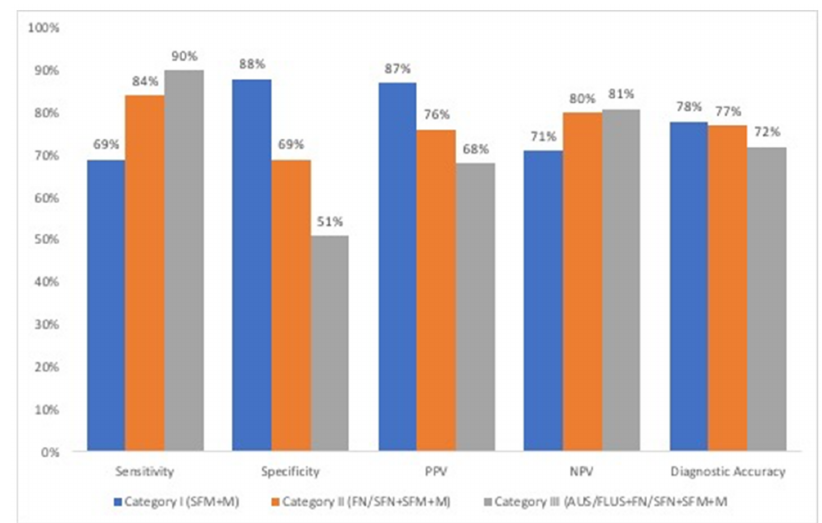
Figure 1. Comparisons derived by different thresholds of FNAB